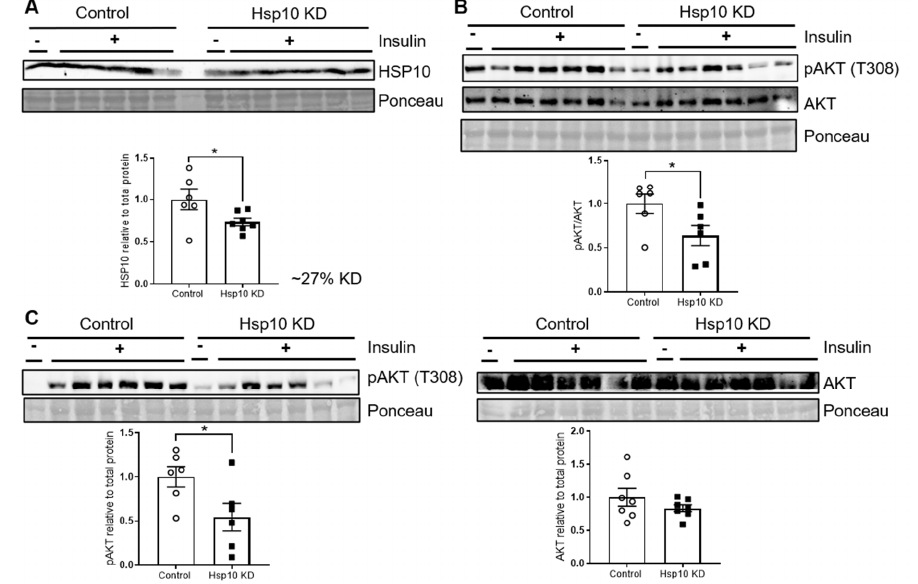
Figure 6. Hsp10 KD in the ARC reduces acute insulin signaling in the ARC and liver. ( A ) Western blot and densitometric analysis of Hsp10 expression of arcuate nucleus samples of control and Hsp10 KD mice, n = 6–7. ( B ) Western blot and densitometric analysis of pAKT (T308) and AKT of arcuate nucleus samples of control and Hsp10 KD mice after insulin injection into vena cava, n = 6–7. ( C ) Western blot and densitometric analysis of pAKT (T308) and AKT of liver samples of control and Hsp10 KD mice after insulin injection into vena cava, n = 6. *, p < 0.05, after two-tailed Student’s t -test. All data are presented as mean ± SEM. Antioxidants 2021 , 10 , x FOR PEER REVIEW